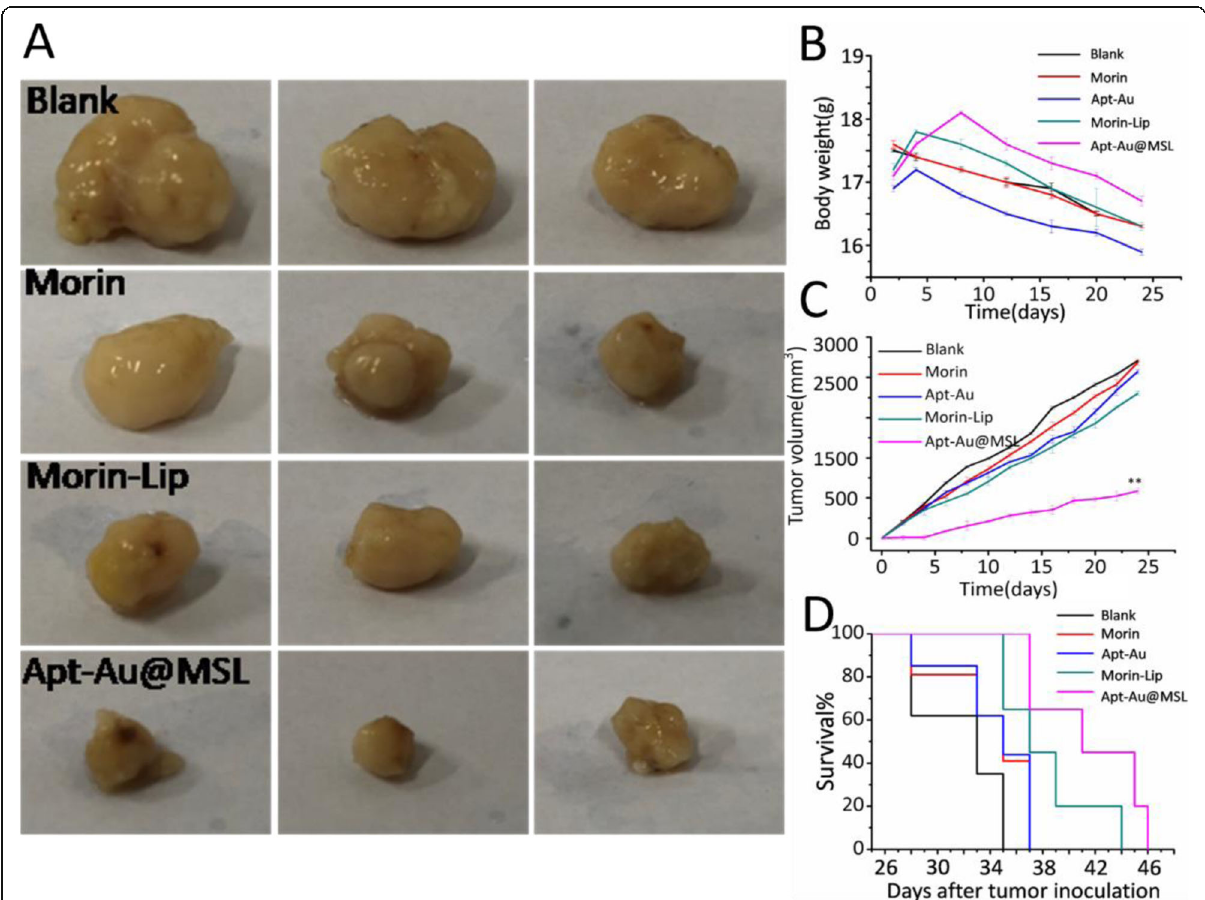
Fig. 9 a In vivo applications of Apt-Au@MSL and photographs of the mice tumor taken 24 days. A dosage of 2 mg/kg was administrated intravenously for all mice ( n = 6 – 8). b Tumor weight of mice in different groups after 24 days. c Tumor volume index for the different treatment groups. The tumor sizes were measured at the indicated time points. d Survival rate of the mice in different group after tumor inoculation. Data are means± SD ( n = 6-8). The intravenous injection of PBS was set as blank group (100 μ L); the treated by Morin and Morin – liposome were set as control group. In vivo therapeutic effects of Apt-Au@MSL in SGC-7901-bearing mice. Data are means ± SD, * P < 0.05, ** P <